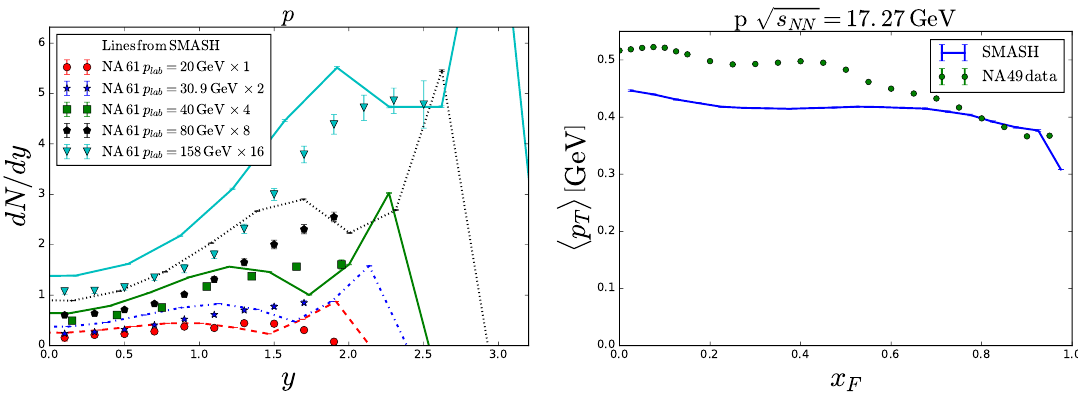
Figure 2. Rapidity spectrum of protons in proton-proton collisions at different energies compared to experimental data [8].